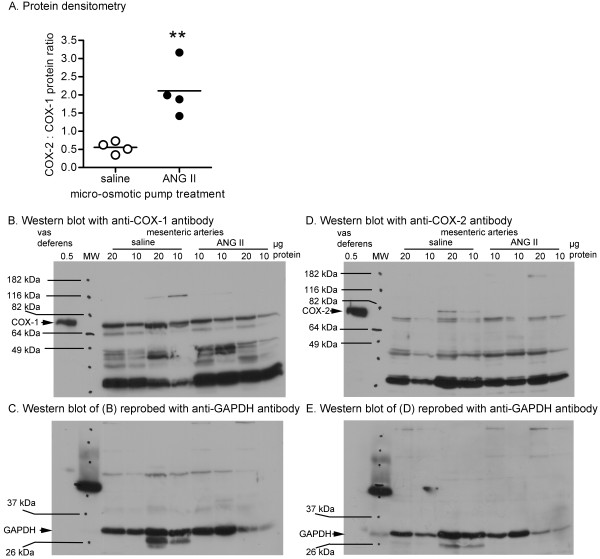
Expression of COX-1 and COX-2 in saline C57 and ANG II C57 mesenteric arteries. C57BL/6J (C57) mice were pretreated with saline or angiotensin II (ANG II) for two weeks prior to experiments. Upper panel (A) summarises protein densitometry data collected from four saline C57 and four ANG II C57 for COX-1 and COX-2. Protein expression ratios (COX-2 to COX-1) were determined from the target bands normalised to the densities of GAPDH. **P < 0.005, saline vs. ANG II, Student's t-test for unpaired data. Lower panels (B - E) show representative data collected from two saline C57 and two ANG II C57 mice indicating immunoreactive bands corresponding to (B) COX-1, (D) COX-2, and after stripping and re-probing membranes, the bands corresponding to (C, E) GAPDH. Each sample was assayed in duplicate at the protein amounts indicated in each lane. Internal reference protein (vas deferens) and relative molecular weight ladder (MW) are also shown. Pen marks indicate the location of prestained MW, which were transcribed by overlay of films on membranes.